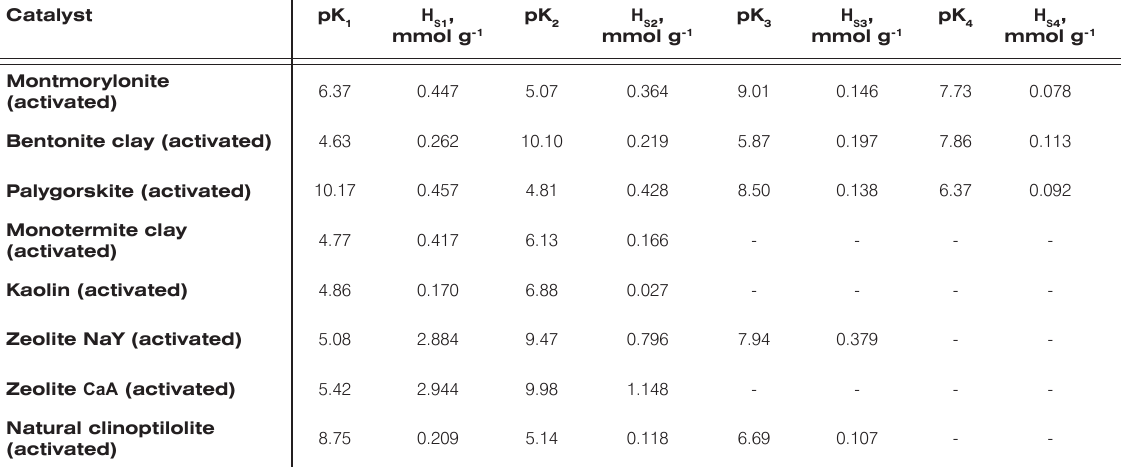
Table 3. The values of strength and concentration of active sites of each type.